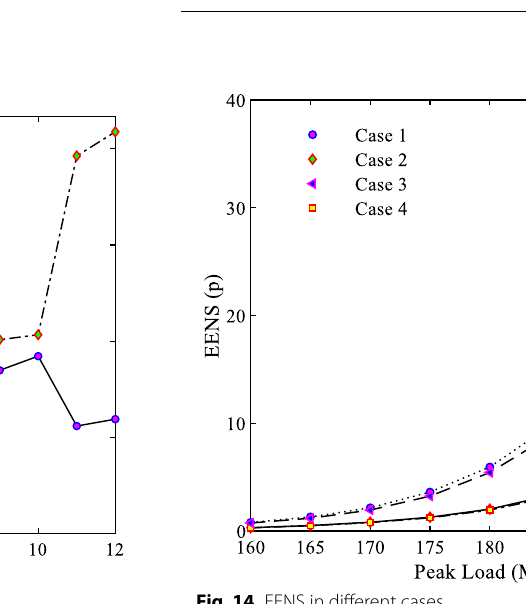
Fig. 14 EENS in different